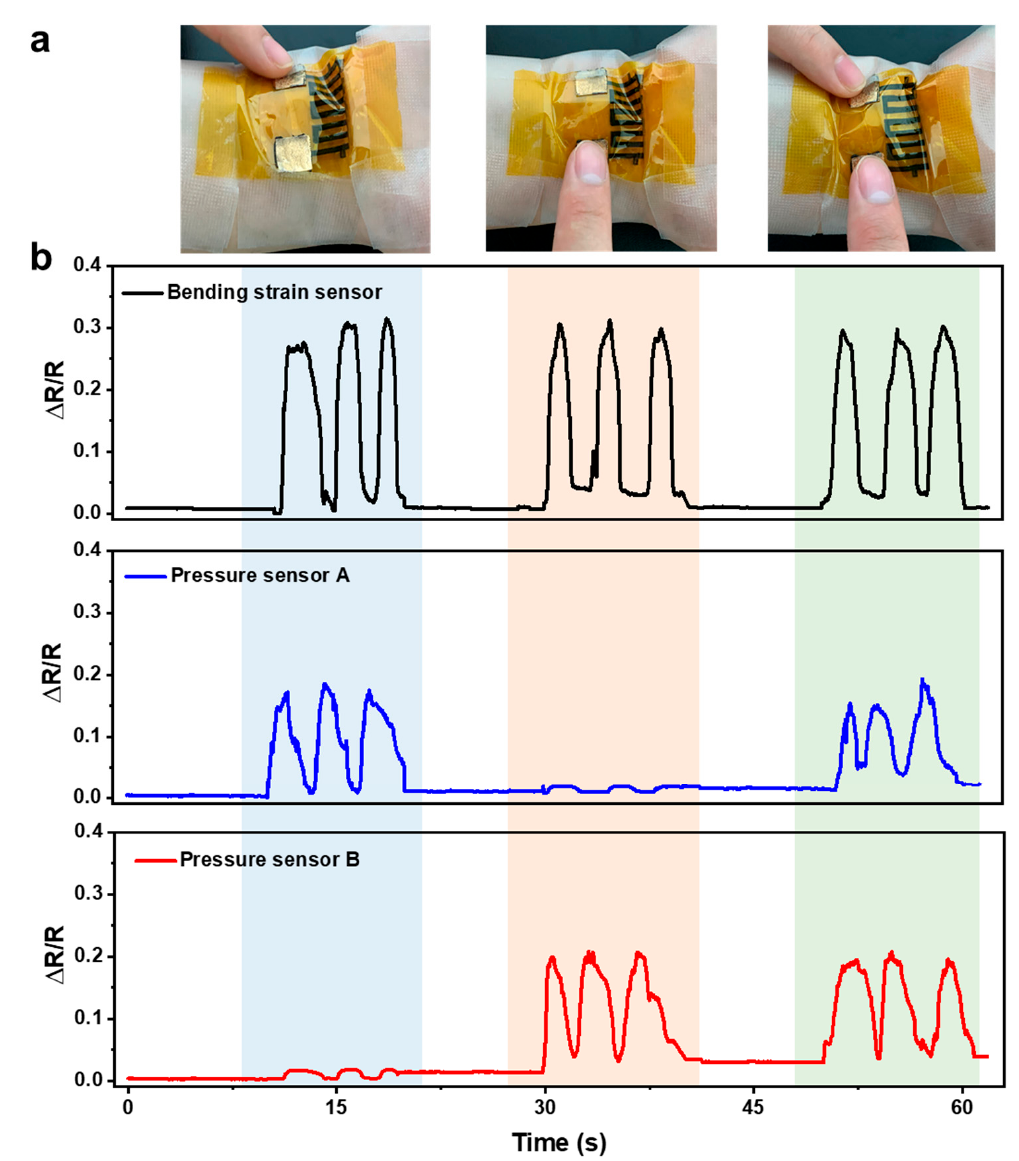
Figure 14. ( a ) Photos showing different actions were carried out when an integrated system was attached to the wrist. ( b ) Signals recorded from different sensors during different actions.